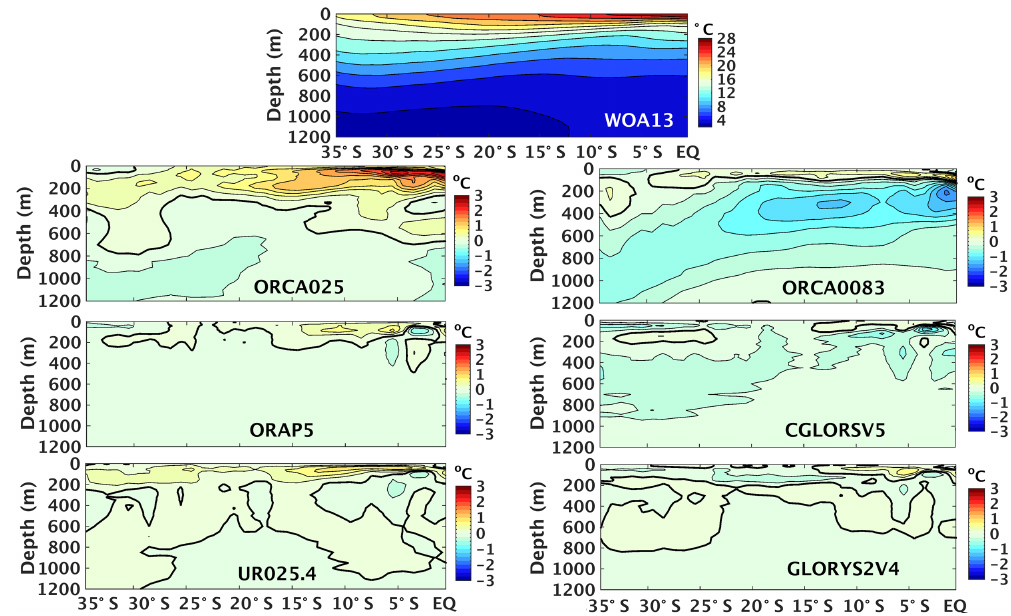
Figure 6. The zonal averaged temperature ( ◦ C) as a function of latitude for WOA13 from 1995 to 2012 (top panel), followed by the zonal averaged temperature of each product from 1997–2010 minus WOA13. The thick solid line represents the 0 ◦ C contour.